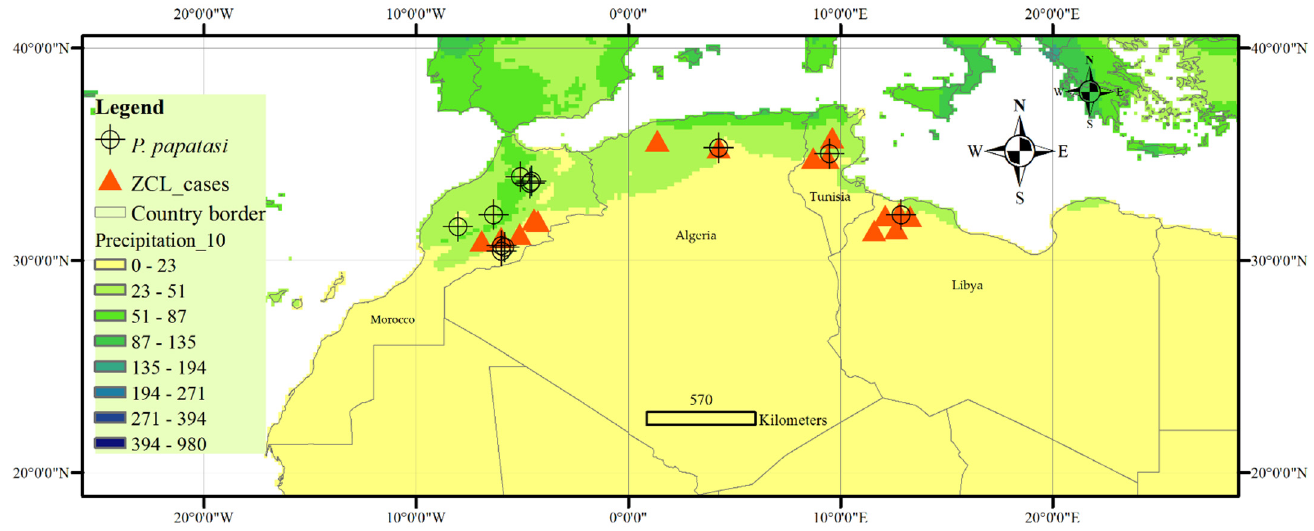
Figure 2. Localization of the North African countries with seasonal activity data of ZCL cases and P. papatasi with the annual distribution of precipitation (mm). ZCL seasonal data: the current study. Climatic data source: ESRI grids, resolution 10 min according to WorldClim 1.4 (current conditions) http://worldclim.com/current, accessed on 15 October 2022 [41] is licensed under a Creative Commons Attribution-ShareAlike 4.0 International License.